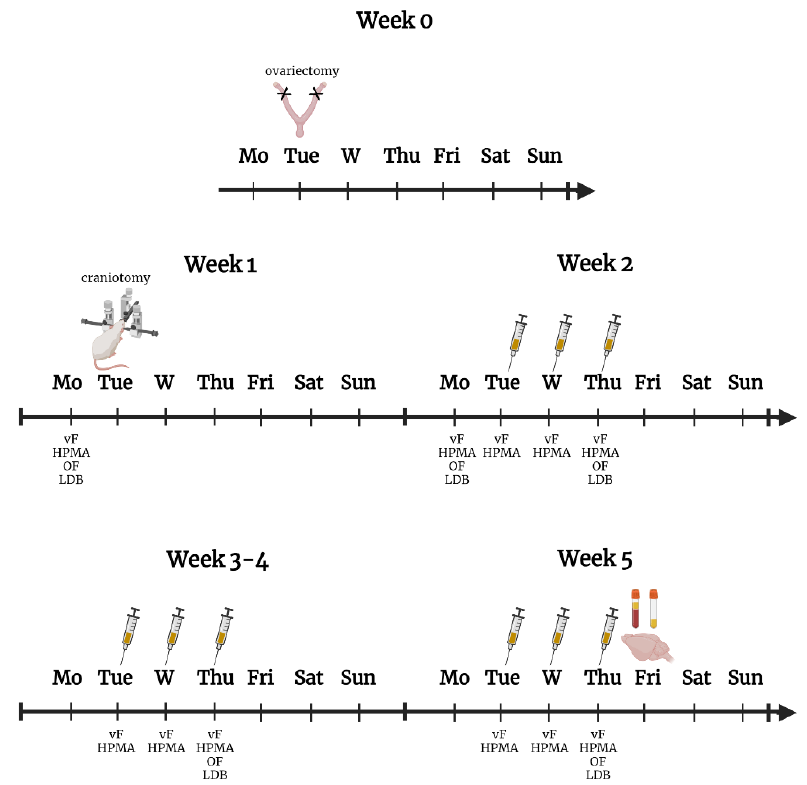
Figure 1. Schematic timeline of the experimental settings. One week before craniotomy, the female rats were overiectomized. After craniotomy, animals received twelve times SIF or IS treatment (needles). Behavioral tests were performed one day before and six days after the craniotomy and on the days when animals received treatment. After the twelfth SIF or IS treatment, the animals were transcardially perfused, and the trigemino-cervical complex was removed for immunohistochemistry. vF—von Frey test, HPMA—hind paw mechanical allodynia test, OF—open field test, LDB—light-dark box test. Created with BioRender.com.